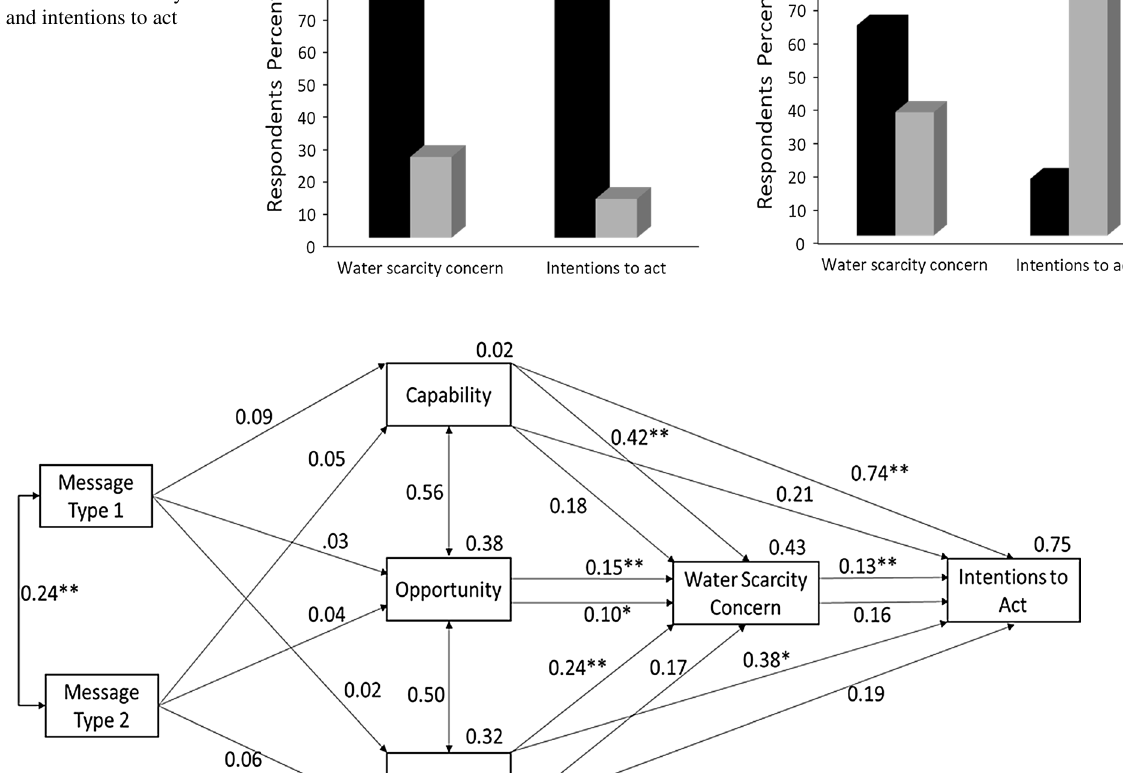
Fig. 1 Effects of a water-saving tips/strategies and b no water- saving tips/strategies message types on water scarcity concern and intentions to act. Yes and No indicate whether message types influence water scarcity concern and intentions to act